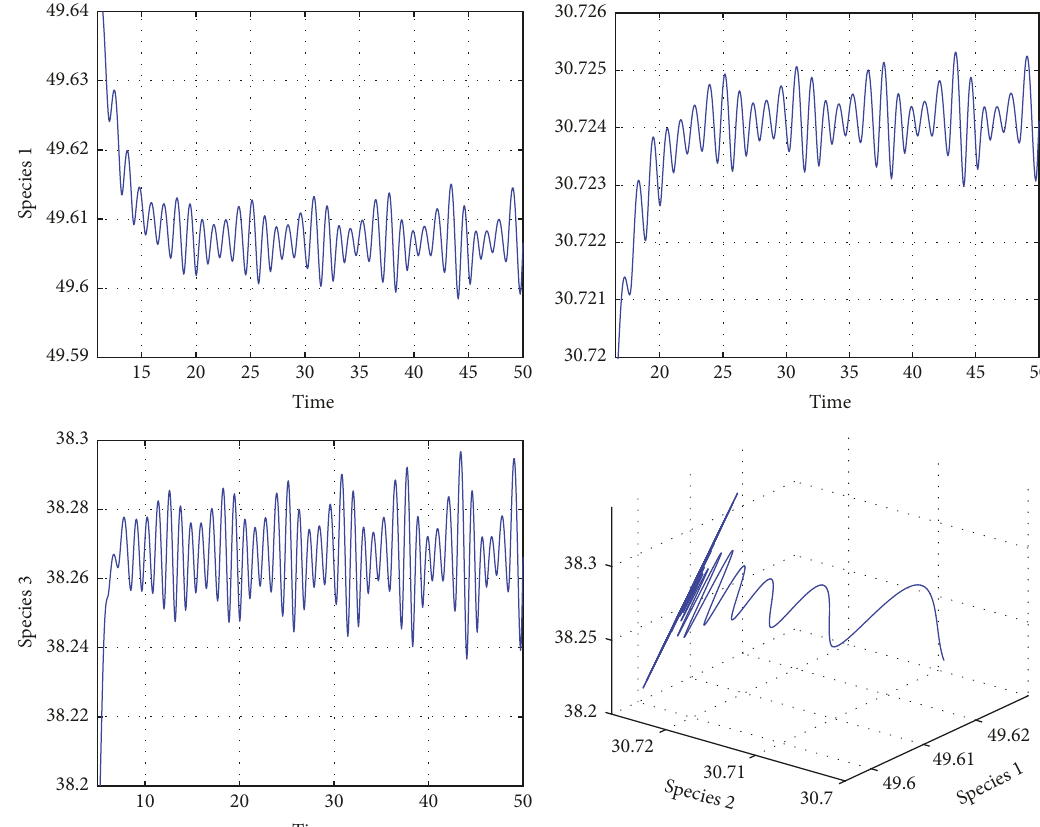
Figure 5: Dynamical behaviors and phase space trajectories of the three marine